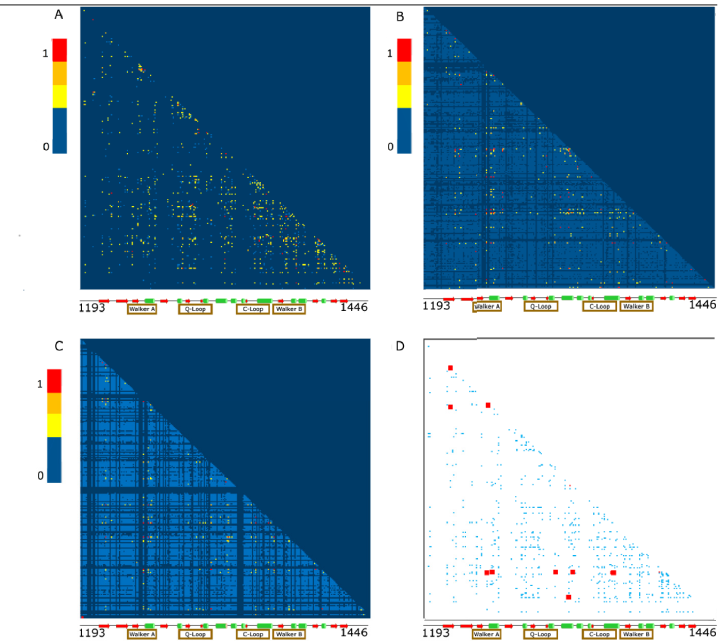
Fig 2. NBD2 matrices for ELSC, OMES, and McBASC analyses. (A) Heat map of the matrix for the McBASC analysis (B) Heat map of the matrix for the ELSC analysis (C) Heat map of the matrix for the OMES analysis (D) Composite heat map depicting high scoring coupled residues (red boxes) identified by all three analyses (ELSC, OMES, McBASC). Cool colors (light blue) represent low coupling scores and warm colors (red) represent high coupling scores. Coupling scores at, or below the average scrambled value were assigned a score of zero and shaded dark blue (See Materials and Methods for details). Matrices are 253 x 253 with the diagonal representing identity. Secondary structure is depicted below the heat maps with same coloring scheme as Fig